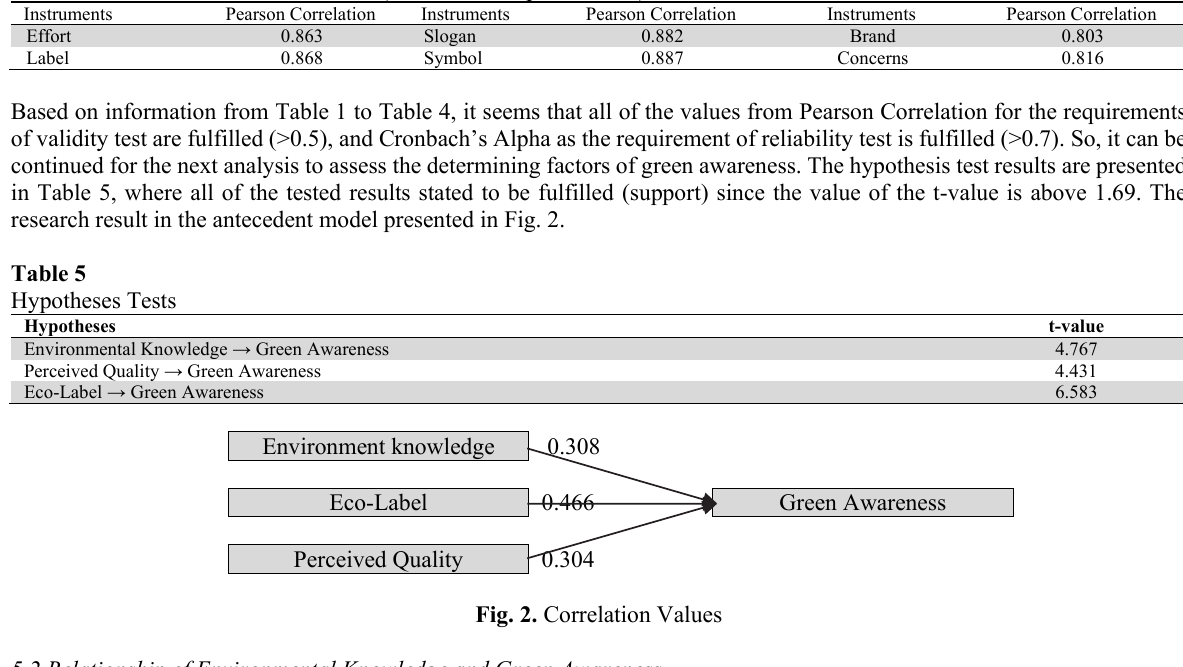
Instrument Tests for Green Awareness (Cronbach’s Alpha = 0.924) Instruments